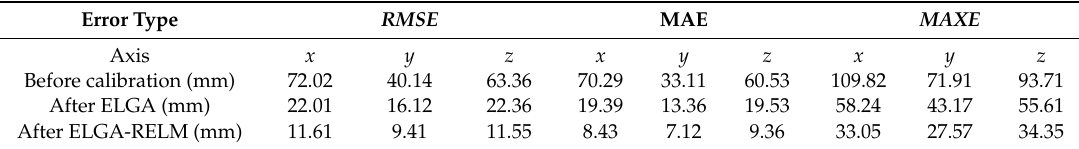
Table 6. The positioning error evaluations of validation experiment.